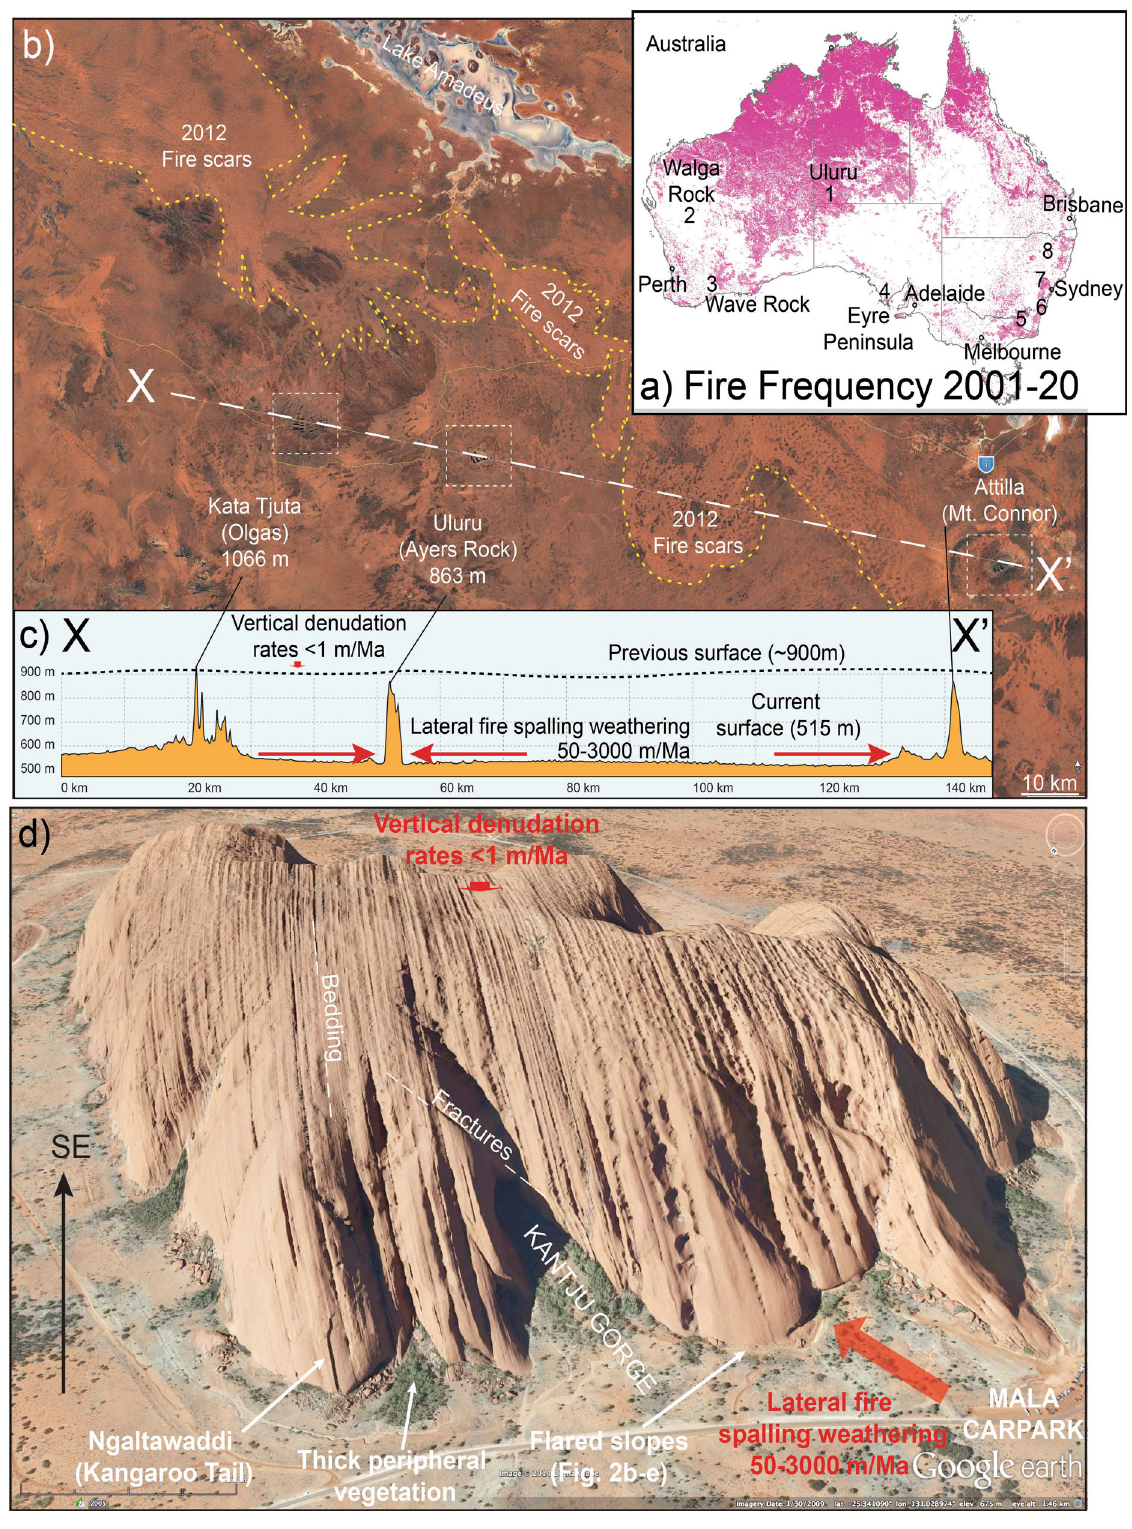
Fig. 1 Study site setting. a Location of study sites and the distribution and frequency of fi res in Australia since 2001 sourced from NASA ’ s Fire Information for Resource Management System (FIRMS) (https:// fi rms.modaps.eosdis.nasa.gov/map/#d:2020-07-29..2020-07-30;@0.0,0.0,3z). Greater intensity of the pink colour indicates increased fi re frequency. Australia has been widely affected by fi re over the past 20 years and that the grassland savannah regions of northern Australia experience regular, almost annual rates of fi re recurrence, whilst the forests of SE Australia experience less regular but more intense fi re regimes. b Aerial view of Uluru region showing recent fi re scars and location of topographic pro fi le X-X ’ . c Topographic pro fi le X-X ’ through Kata Tjuta, Uluru and Mount Connor. d Aerial perspective view of the iconic inselberg Uluru (Ayres Rock) in central Australia and the location of signi fi cant fl ared slopes around its periphery. Source: Google